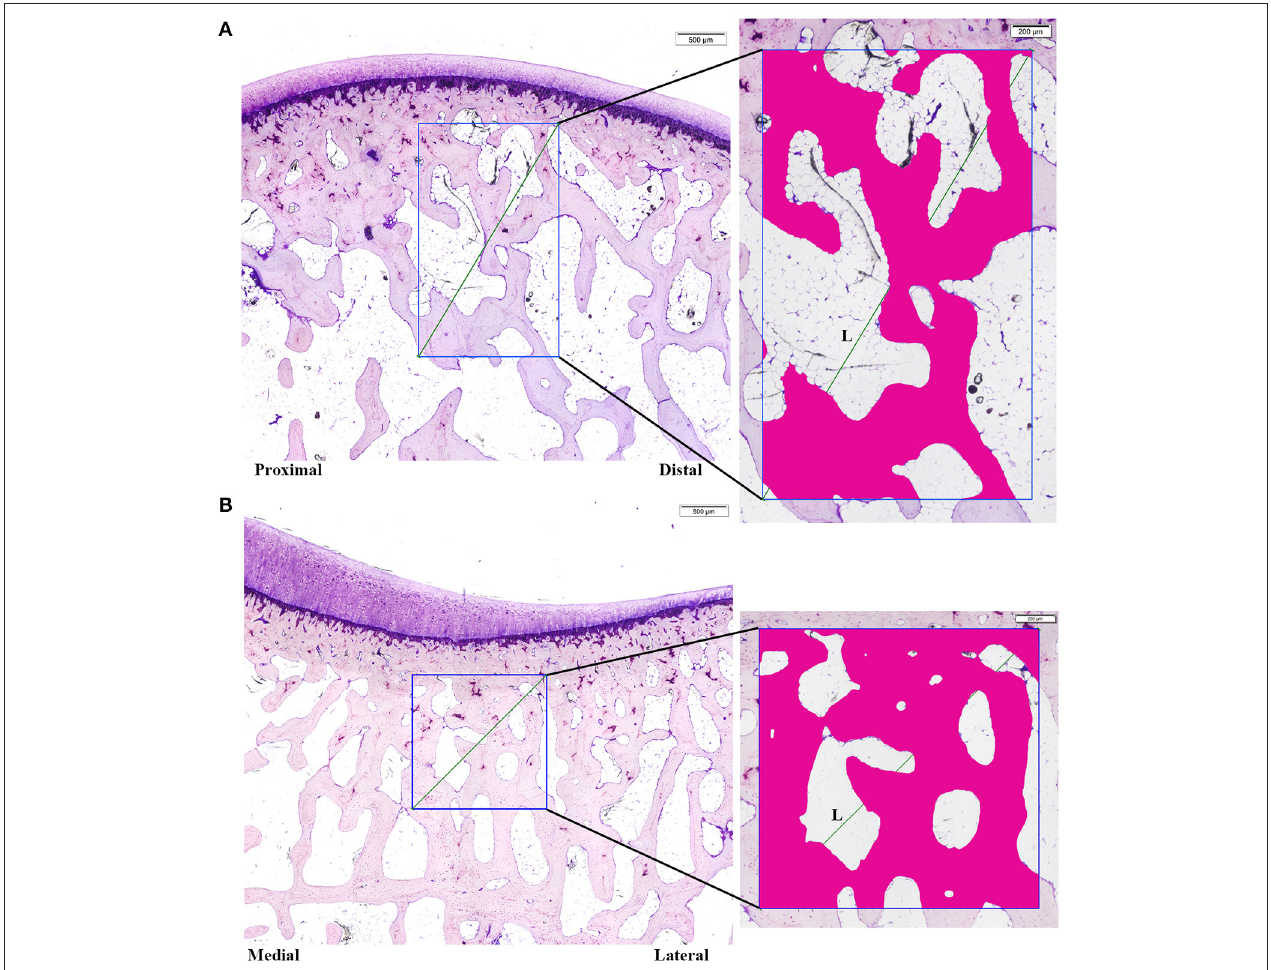
FIGURE 3 | Trabecular subchondral bone histology measurements. (A) Femoral ROI (1.5 × 2.5mm) (B) Tibial ROI (1.5 × 1.5mm). Tb.A: % of trabecular bone in the ROI; Tb.Sp measured on the diagonal of the ROI [Tb.Sp = (L/Tb.N)-Tb.Th].